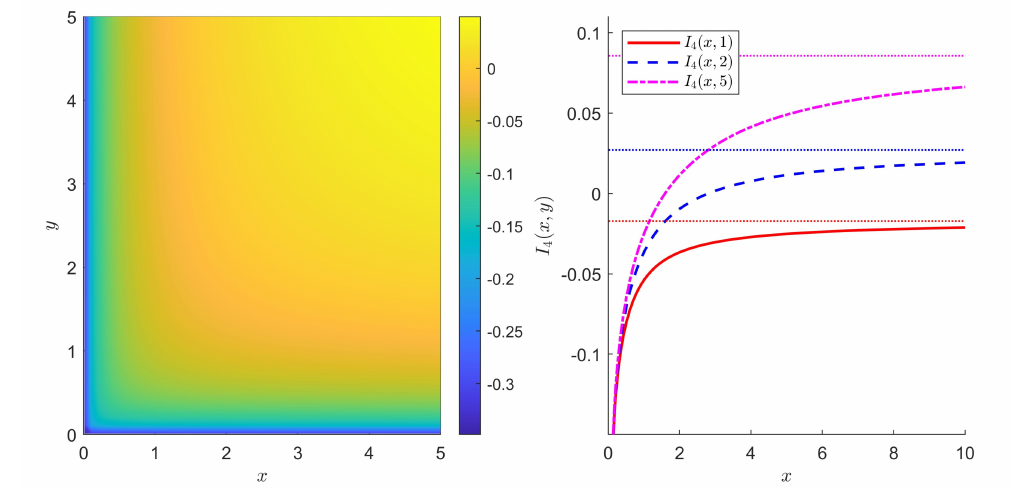
Figure 2. A surface plot of I 4 ( x, y ) , as well as a plot of I 4 ( x, y ) for fixed values of y . We also compare I 4 ( x, y ) at fixed y to the asymptotic value at infinite x denoted by the dotted